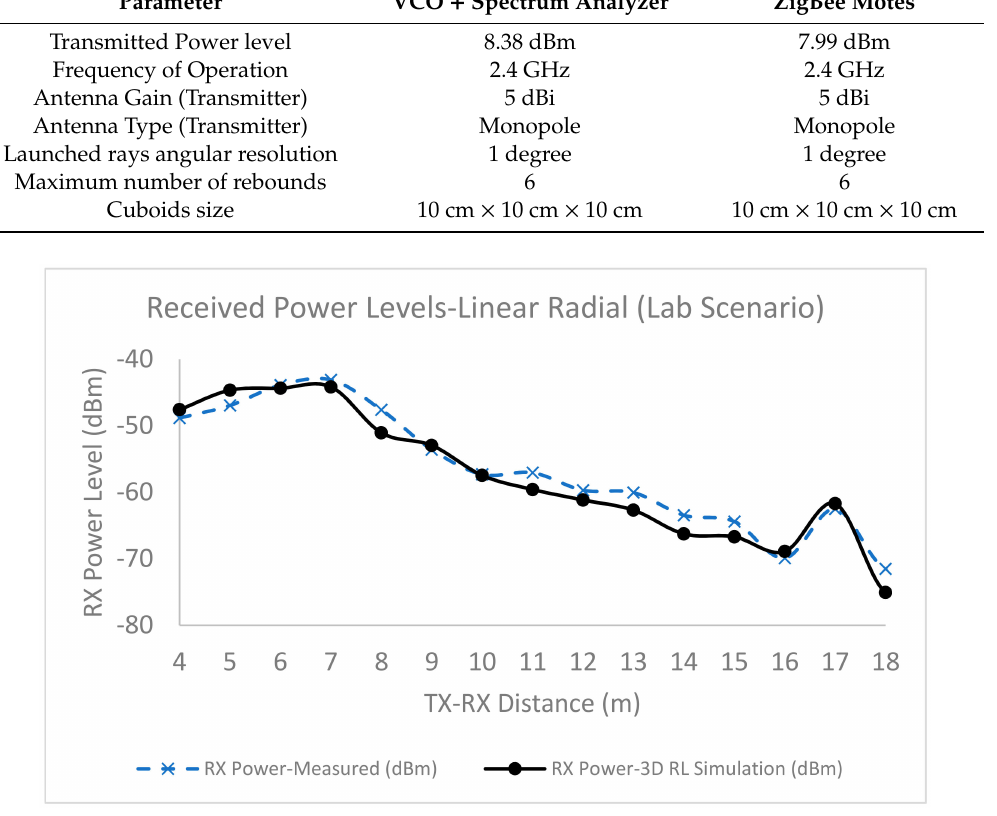
Figure 10. Comparison between simulation and measurement results of the received power levels for a linear Transmitter-Receiver radial within an indoor lab